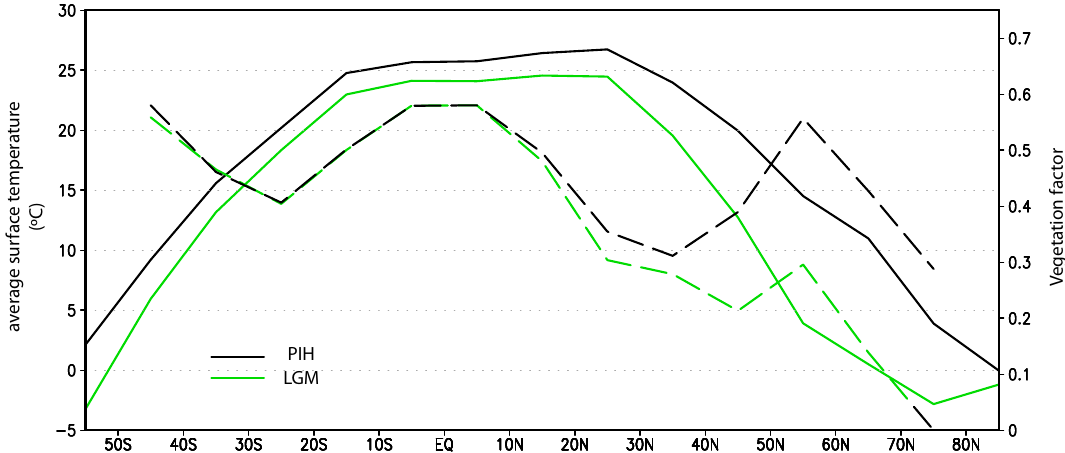
Fig. 3. CLIMBER-2 simulated PIH temperature (solid black line) and LGM temperature (solid green line) for the NH summer months, and annual-mean grid-box vegetation factor (Sect. 2.2) during the PIH (dashed black line) and LGM (dashed green line). Note that the vegetation factor is a weighted average of tree cover (60%) and grass cover (40%). All data are integrated zonally and by 10 ◦ latitude